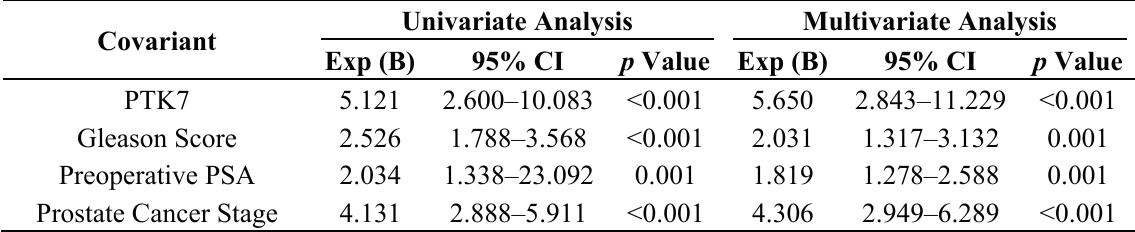
Table 5. Prognostic value of PTK7 expression for the overall survival in univariate and multivariate analyses by Cox